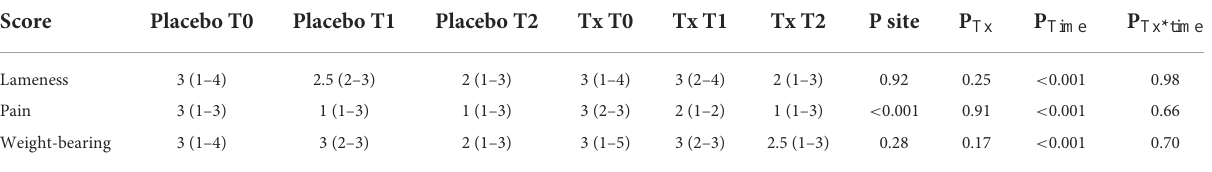
TABLE 2 Results of lameness, pain, and weight-bearing scores graded on a 1–5 scale (1 = best; 5 = worst) in dogs treated with either a cannabidiol (CBD) and cannabidiolic (CBDA) rich hemp product (2–2.5 mg/kg orally every 12h; n = 22) or a placebo (sesame seed oil every 12h, n = 19) for 4 weeks after a tibial plateau leveling osteotomy surgery.